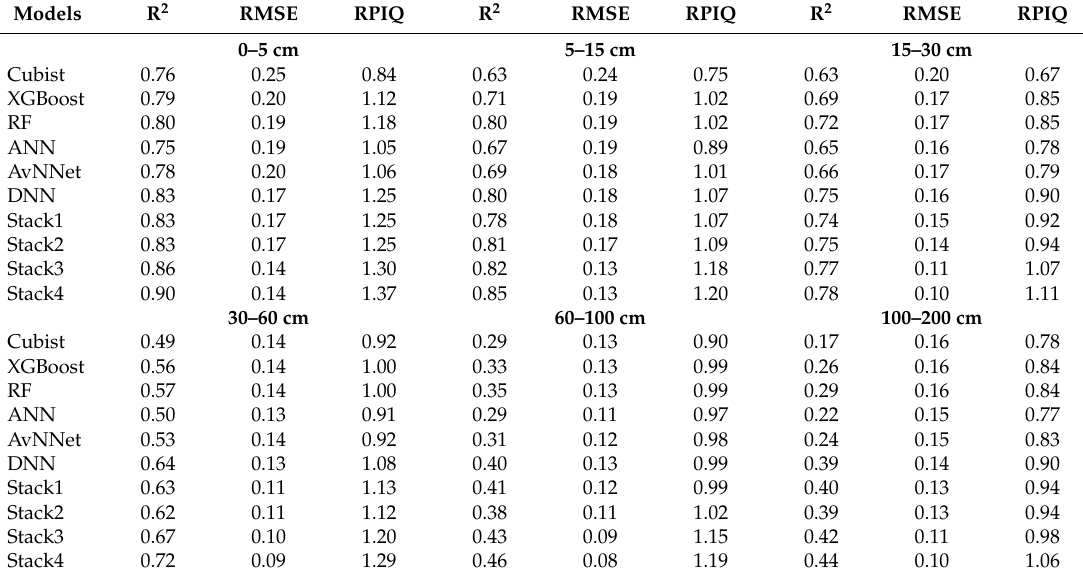
Table 5. Performances of the ML models for SOC content at six standard depths in the arid site.